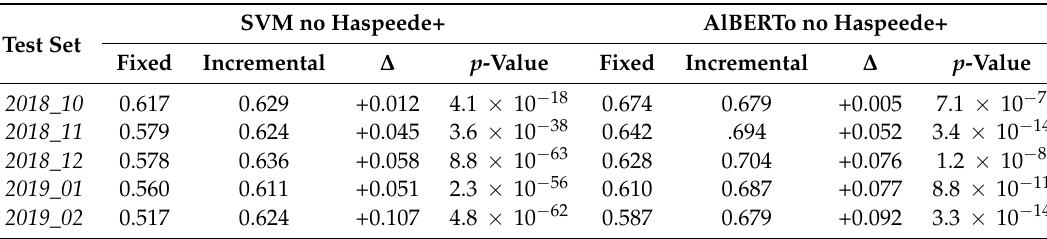
Table 8. Comparison of the macro F1 scores between the fixed and incremental windows experiments.